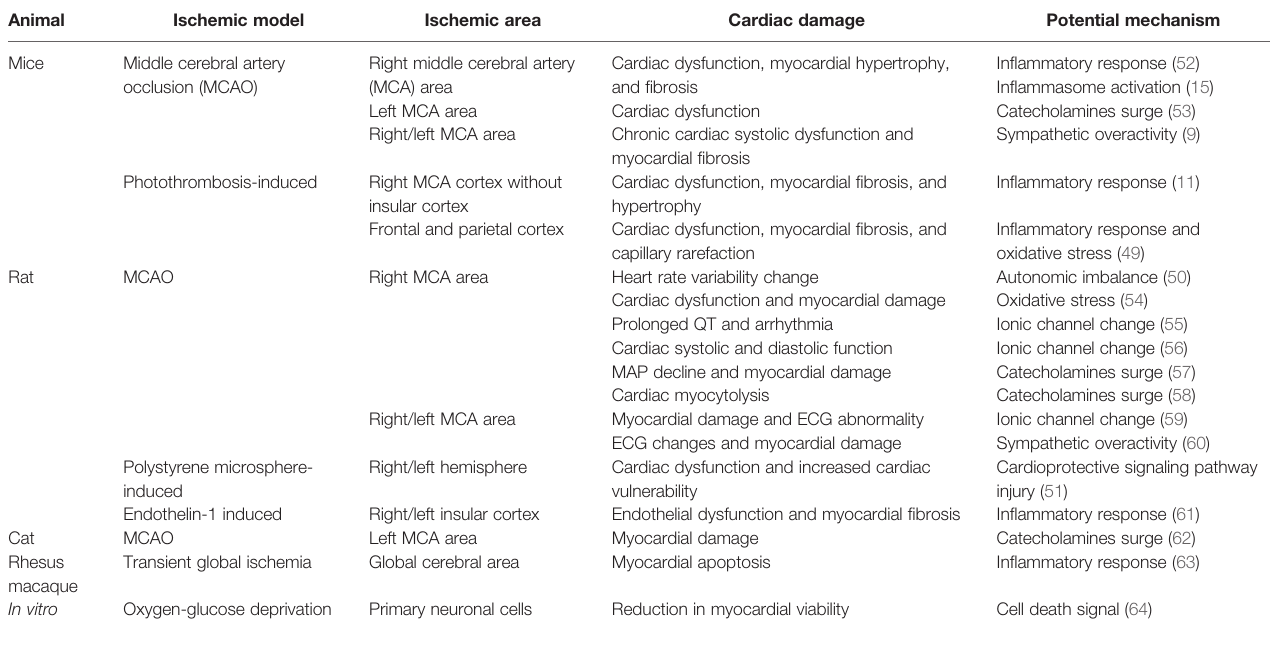
TABLE 2 | Cardiac damage in experimental animals after IS.